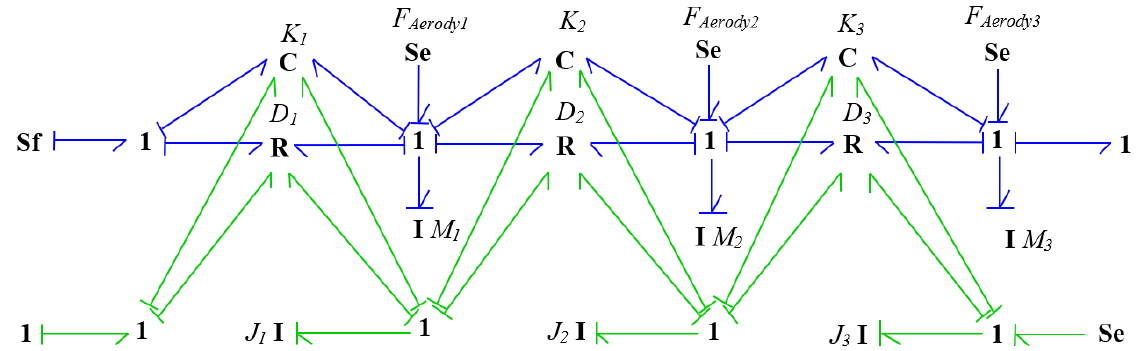
Figure 3. Bond graph model of wind turbine blade structure with three sections.